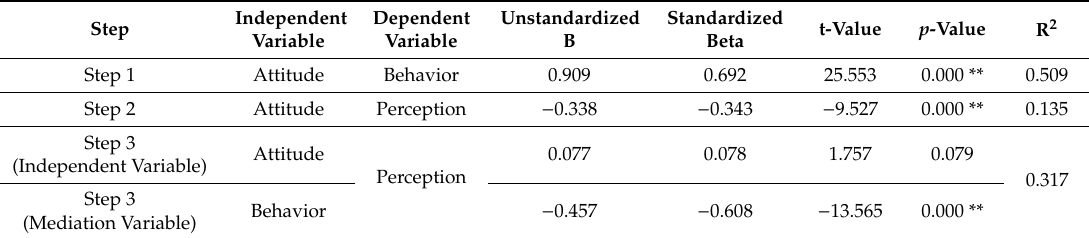
Table 5. Testing the low-involvement